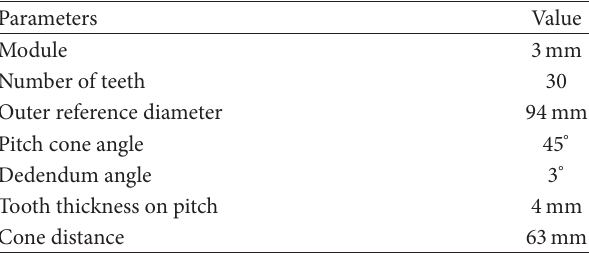
Table 3: Bevel gear